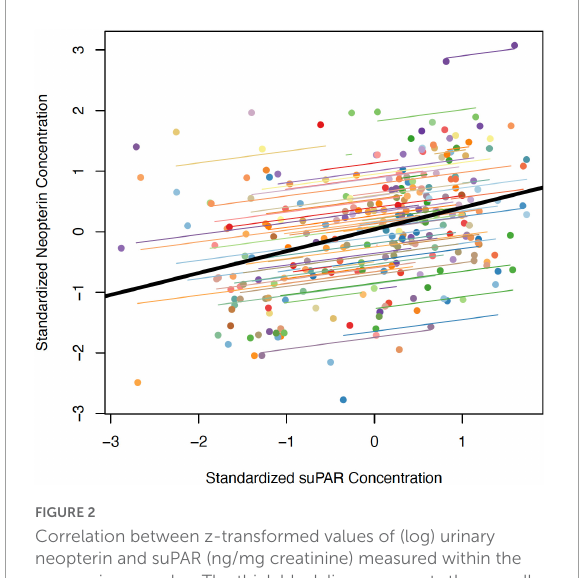
FIGURE3 Marker genes for CD14– and CD14+ monocytes were more highly expressed among older individuals compared to younger individuals ( p = 0; as indicated by the * symbol). Marker genes significantly associated with aging are fully colored, marker genes not significantly associated with aging at a 10% FDR are